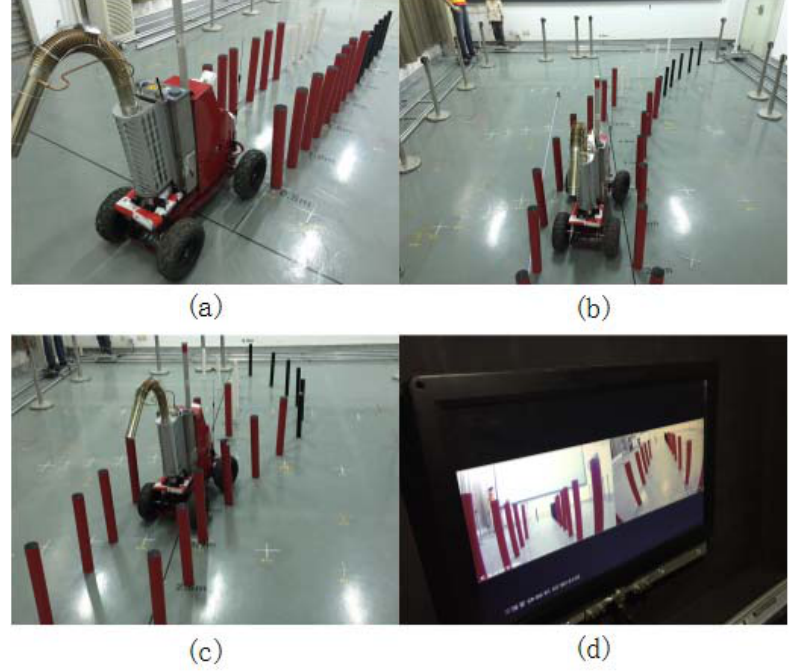
Figure 10. Laboratory tests: ( a ) straight line; ( b ) right-turn; ( c ) S-turn; and ( d ) the display of the front camera.